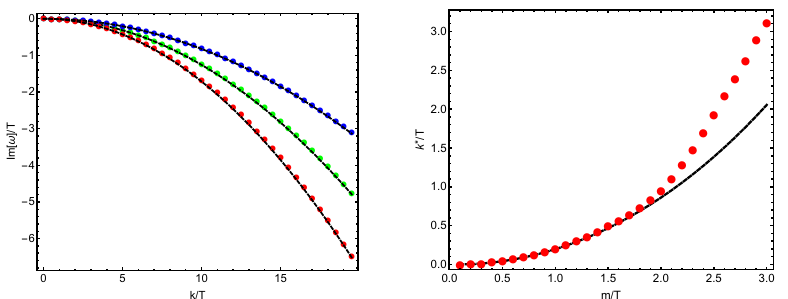
Figure 8 . Left: the lowest mode in the longitudinal sector for very large graviton mass m=T (cid:29) 1 ( m=T 2 f 50 : 66 ; 105 : 13 g red to blue), i.e. in the incoherent regime. The dashed black line is eq. (3.14). Right: the momentum of the poles collision k ? extracted from the numerical data (red bullets). The dashed line is the hydrodynamic approximation of eq. (3.13) which show good agreement for m=T (cid:28) 1. At very large m=T , the data increase linearly in the dimensionless EXB strength m=T